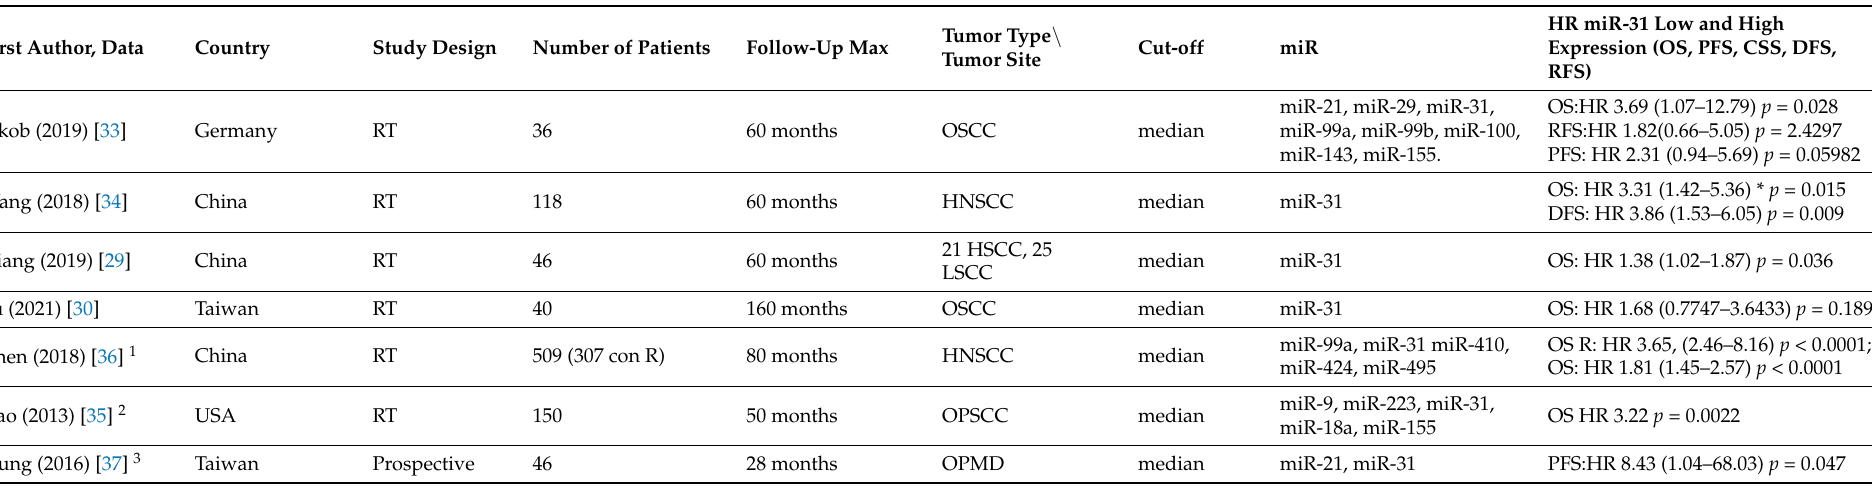
Table 2. The data extracted from the four articles included in the meta-analysis and from the three articles excluded are reported in the present table. R (radiotherapy), OPMD (oral potentially malignant disorder).